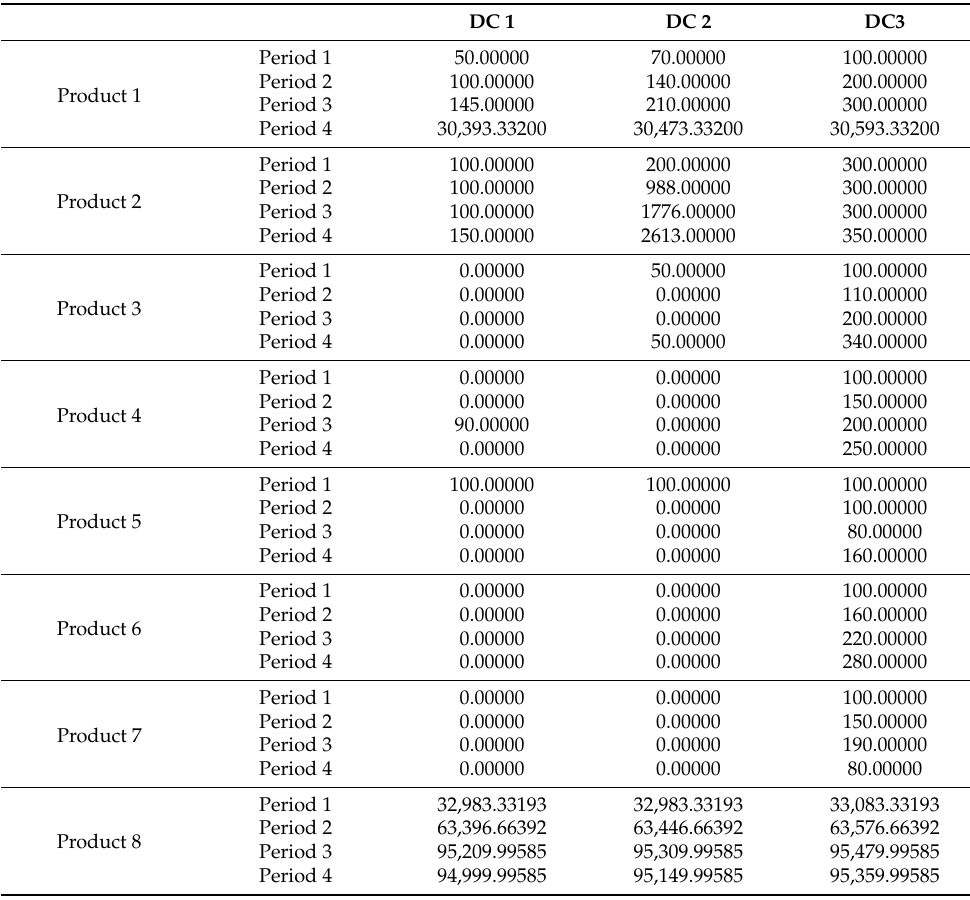
(cid:16) (cid:17) C jvt